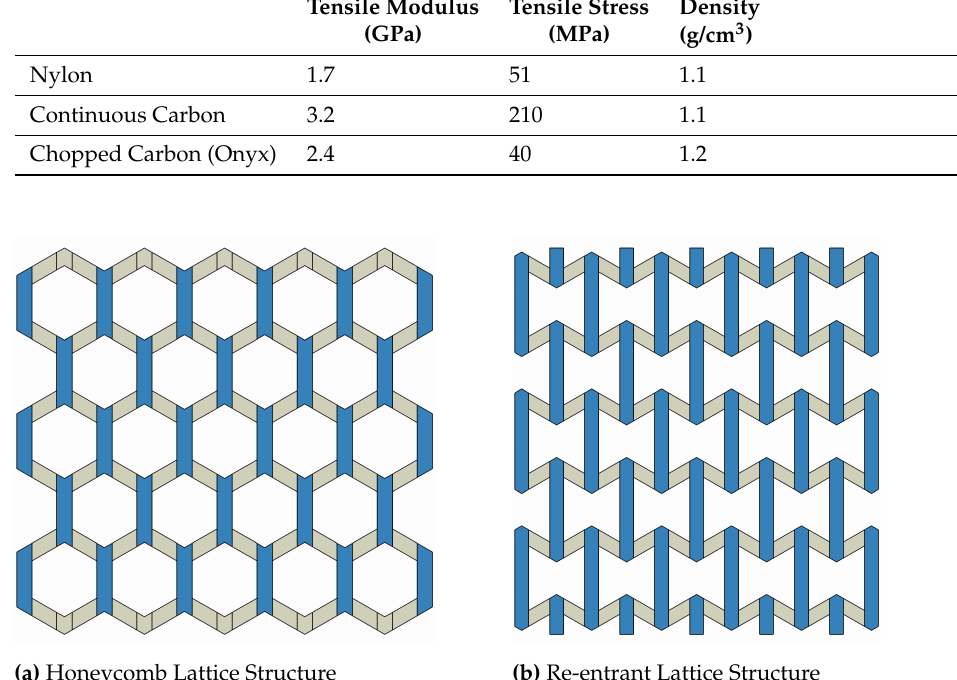
Figure 3. Composite ligaments highlighted with blue color in otherwise nylon